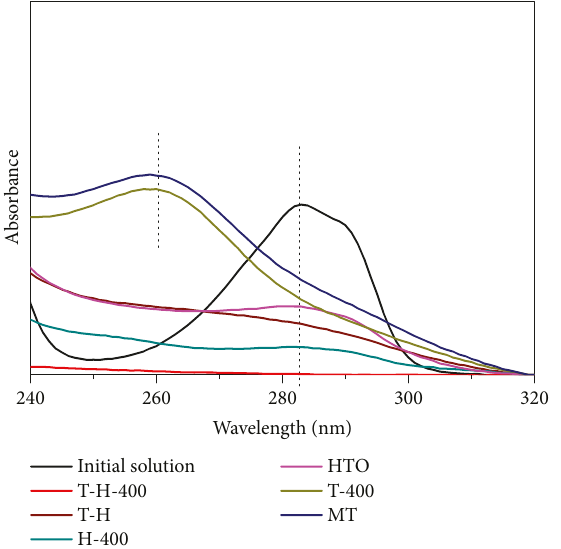
Figure 11: The full-scan UV – Vis absorption spectra of 2,4-DCP solutions for all samples after photodegradation by for 1 h.